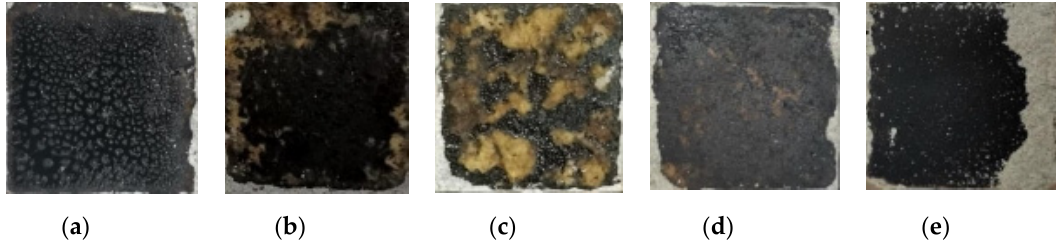
Figure 13. Changes in fracture surface with increased curing age (using PG76-22 modified asphalt). ( a ) 3 d, ( b ) 7 d, ( c ) 14 d, ( d ) 21 d, ( e ) 28 d.